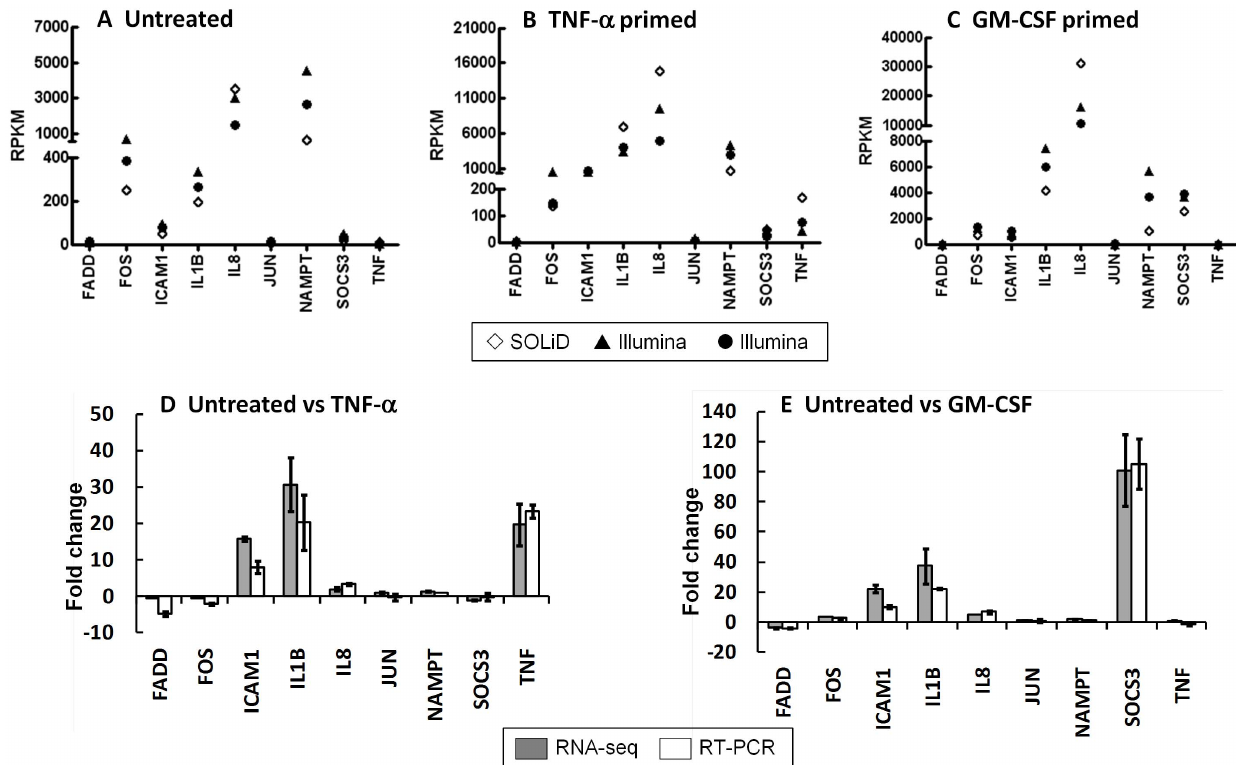
N m Illumina, n=2) in (A) untreated, (B) TNF- a -treated